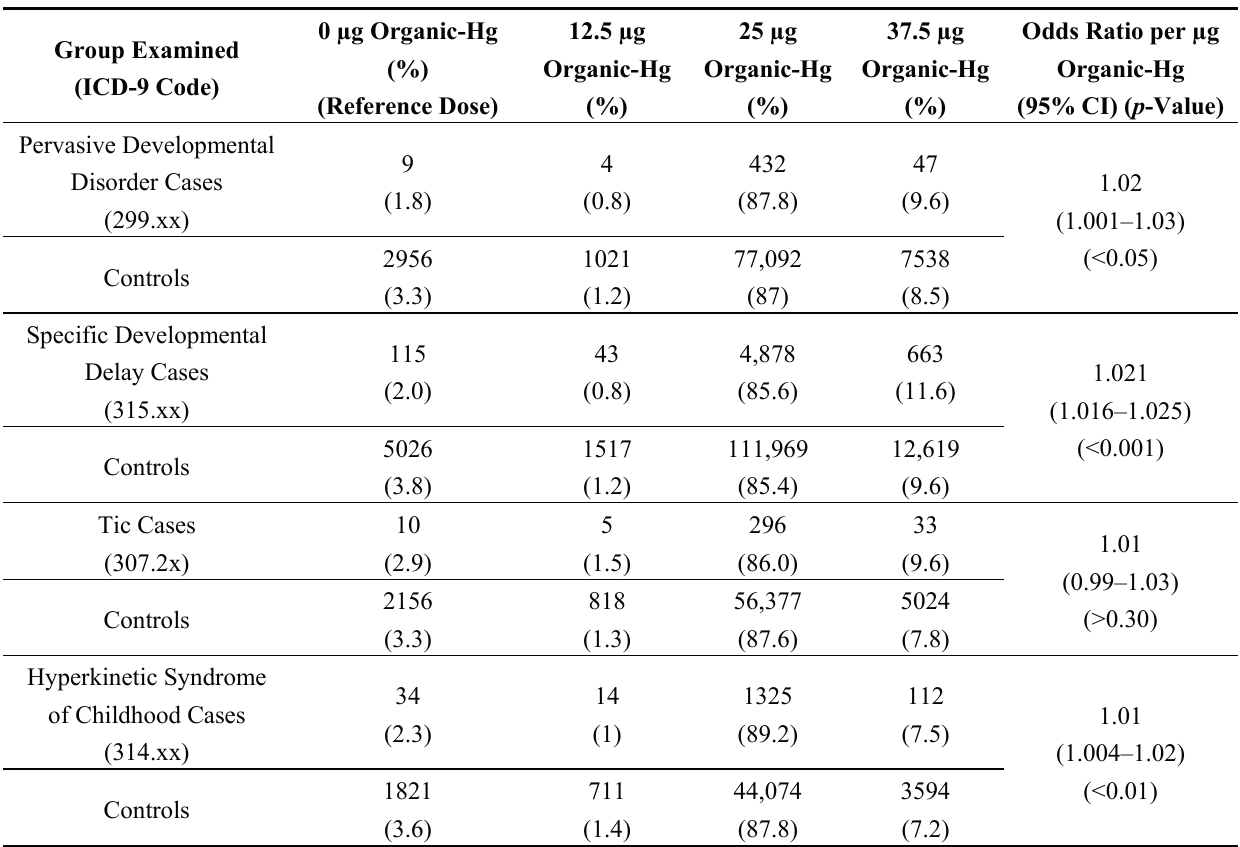
Table 6. A summary of the effect of inadequate follow-up of controls on the risk of exposure to organic-Hg from thimerosal-containing hepatitis B vaccine administration within the first six months of life for the cases diagnosed with a studied ND and the reduced follow-up controls 1